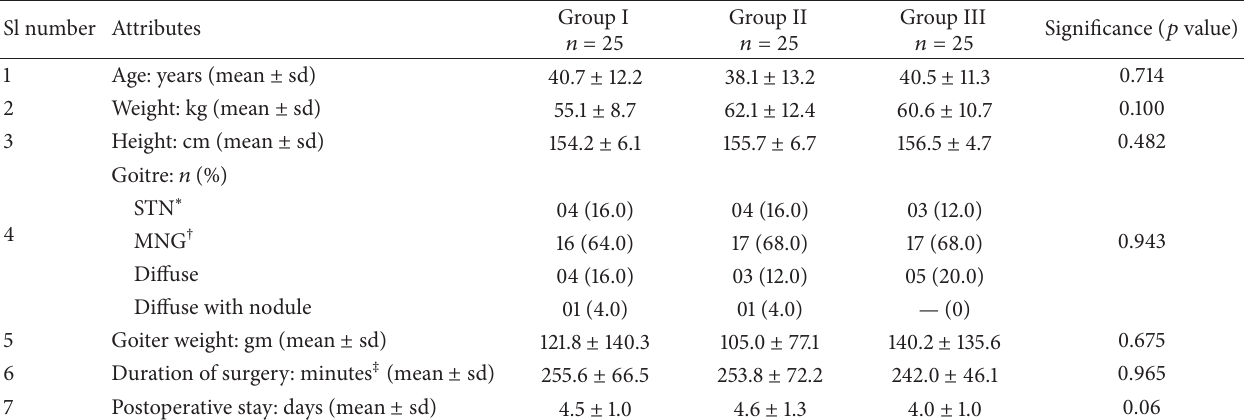
Table 1: Clinicopathologic profile of various groups.